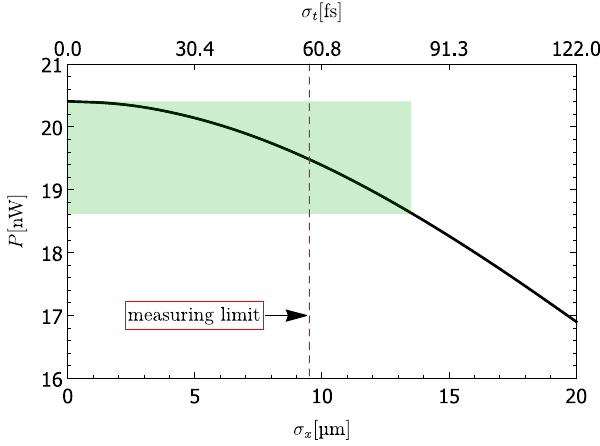
FIG. 16. Calculated SPR power for short bunch lengths at the smallest available grating period D ¼ 0 . 75 mm. At a bunch length of σ x ≲ 10 μ m, changes in σ x cannot be resolved by the detection system. The green box indicates the measuring accu- racy of the detection system of (cid:3) 4 . 4%